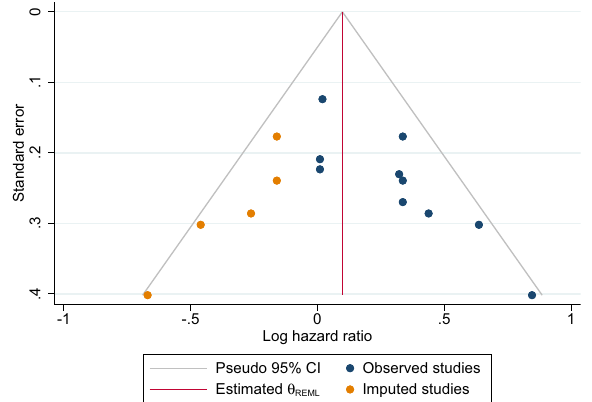
Fig. 4 Funnel plot assessing the presence of publication bias in the disease-free survival analyses. * The Duval and Tweedie trim- and- fi ll method 30 was used to adjust for publication